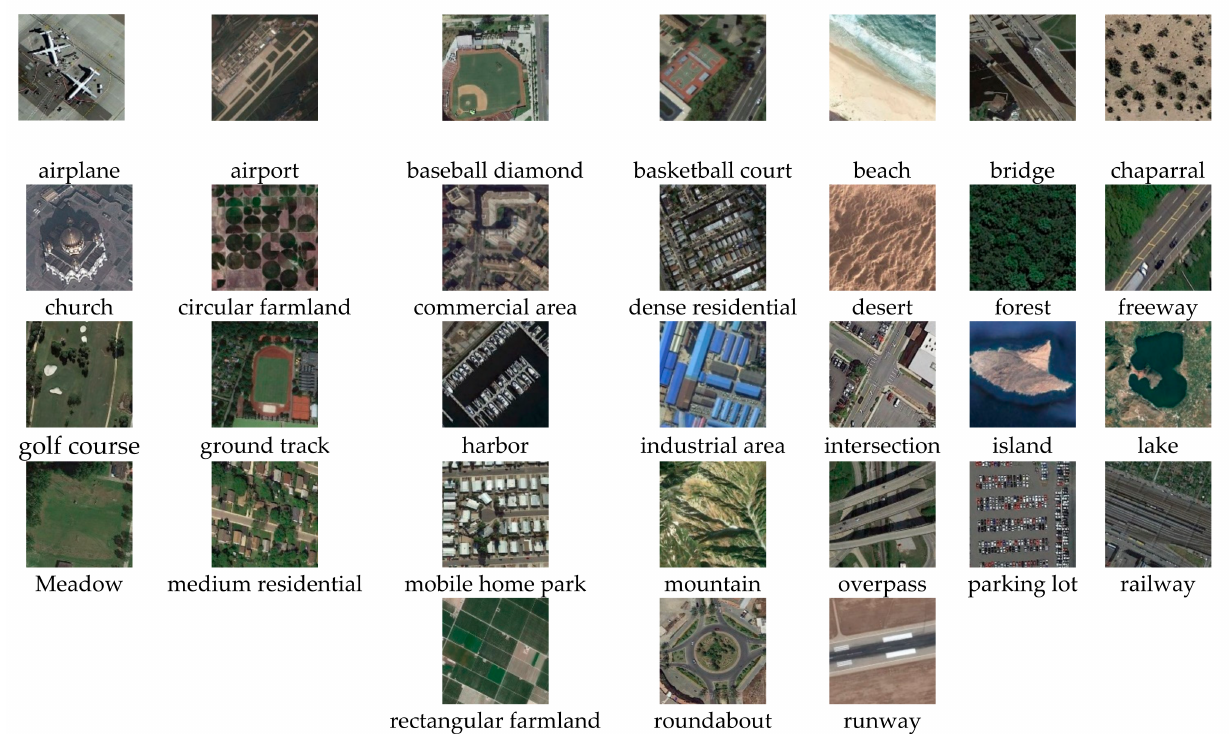
Figure 4. Example images of the OPTIMAL-31 dataset.